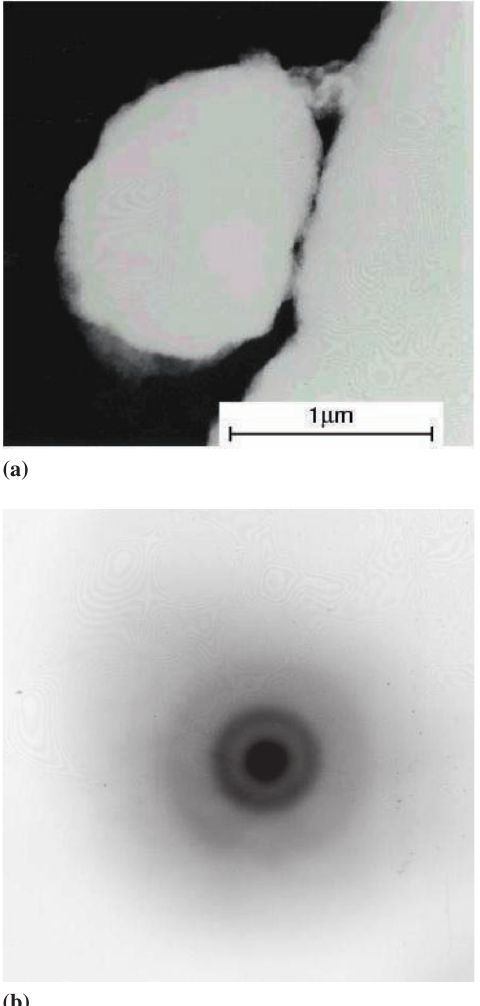
Figure 4. The TEM observation results for the initial sam- ple A. (a) Bright field image, (b) electron beam diffraction pattern.